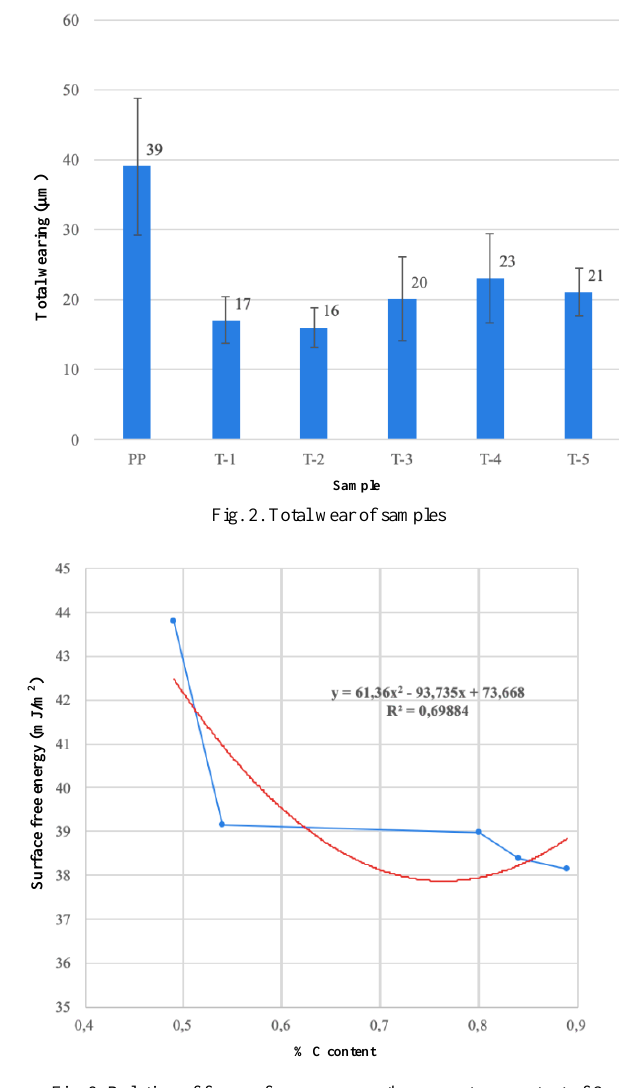
Fig. 3. Relation of free surface energy on the percentage content of